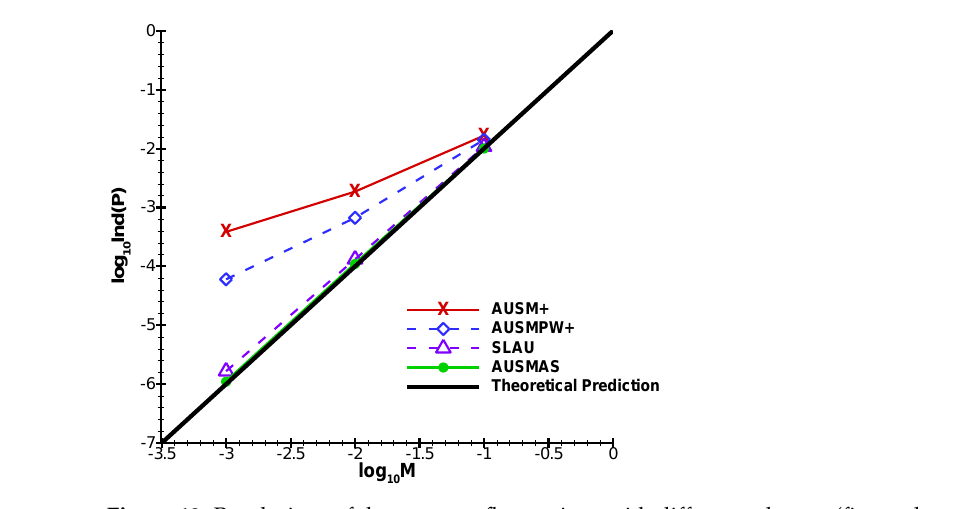
Figure 13. Resolutions of the pressure fluctuations with different schemes (first order reconstruction, dense grid).